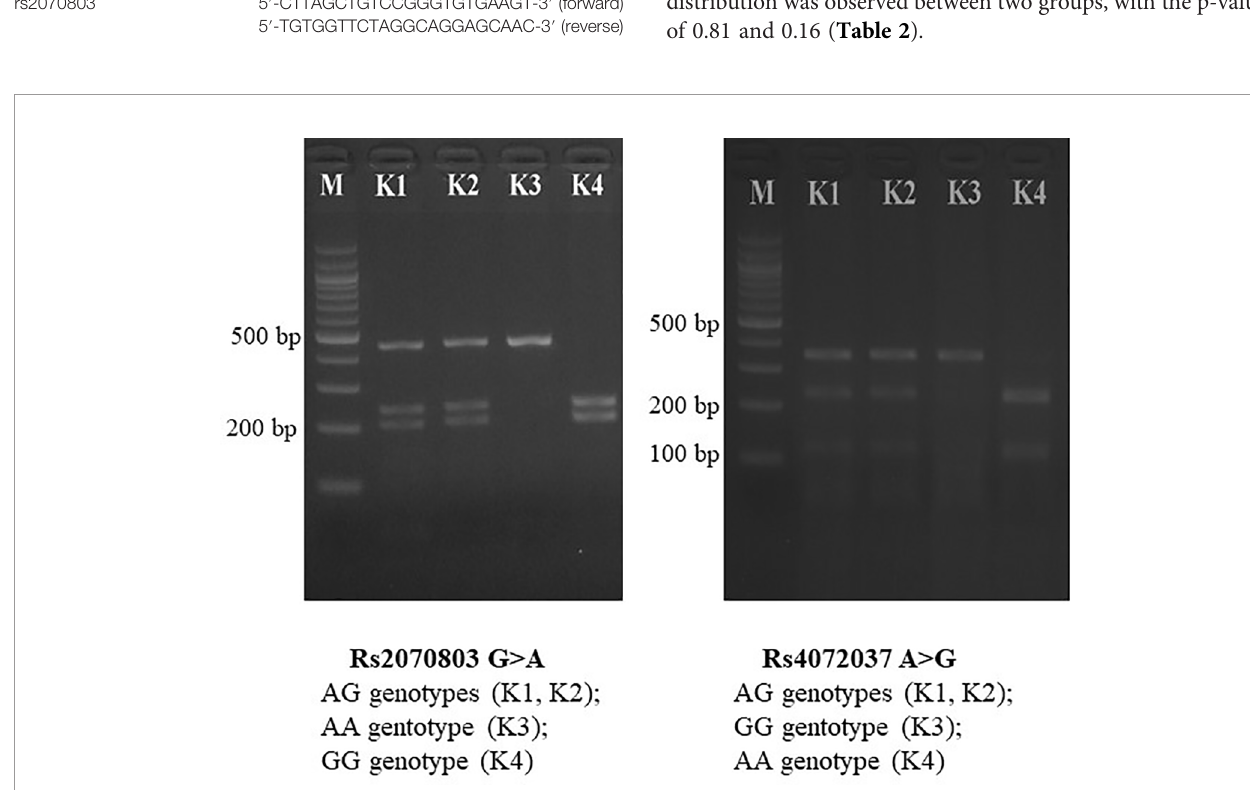
FIGURE 1 | PCR-RFLP for MUC1 gene polymorphisms. PCR-RFLP, polymerase chain reaction – restriction fragment length